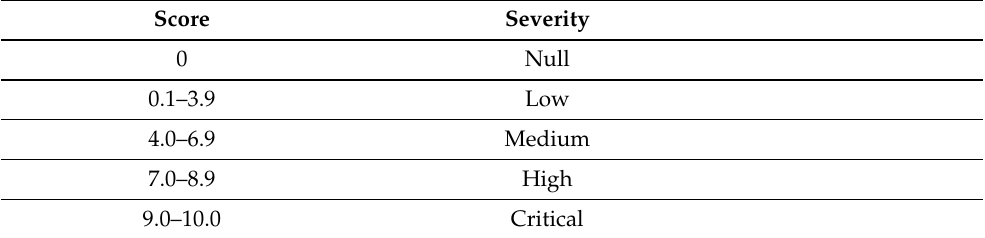
Table 3. Correspondence between CVSS score and qualitative value